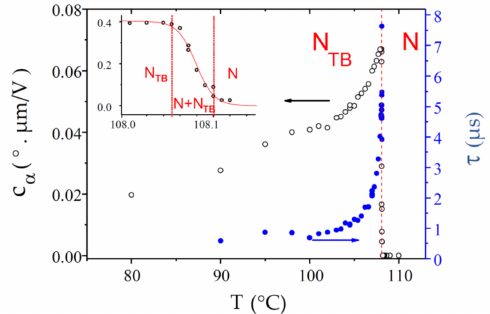
Figure 11. Temperature dependences of the ECE parameters, c α ( T ) and τ ( T ) , measured in the N TB phase of the bent-shaped dimer CB6OCB. The inset shows a magnification of the N-N TB biphasic coexistence